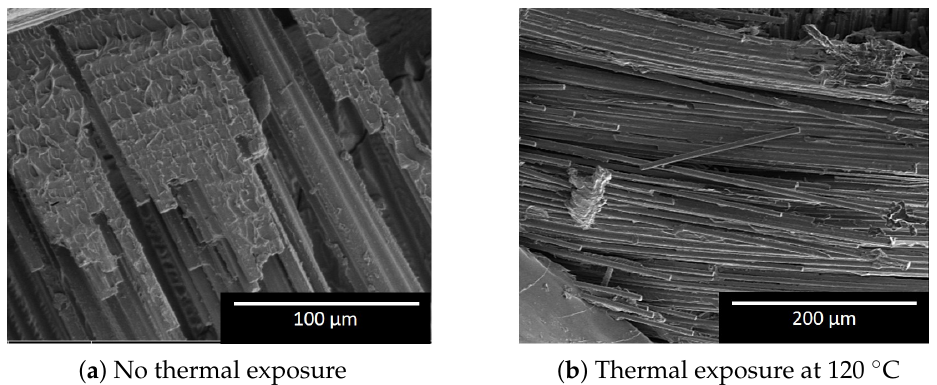
Figure 6. SEM images of the fracture surface of the tubes with and without thermal exposure.